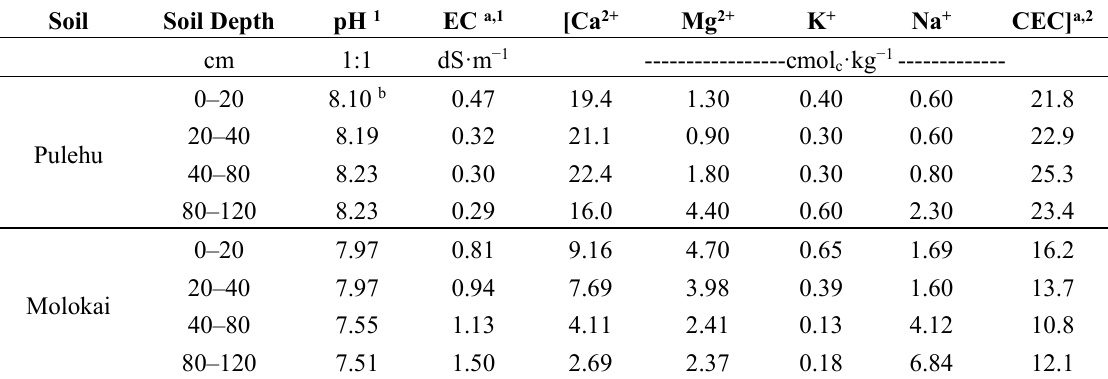
Table 1. Soil Chemical Properties of the Experimental Fields.